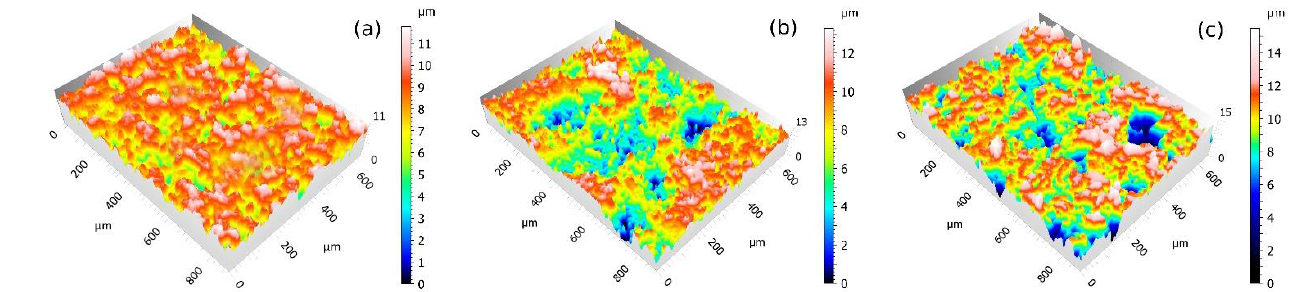
Figure 4. 2D images of the coatings after wear process during 4 s projecting with brown corundum particles at 0.4 MPa, obtained with Leica DVM6 confocal microscope: ( a ) PFA, ( b ) FEP, and ( c ) PTFE.